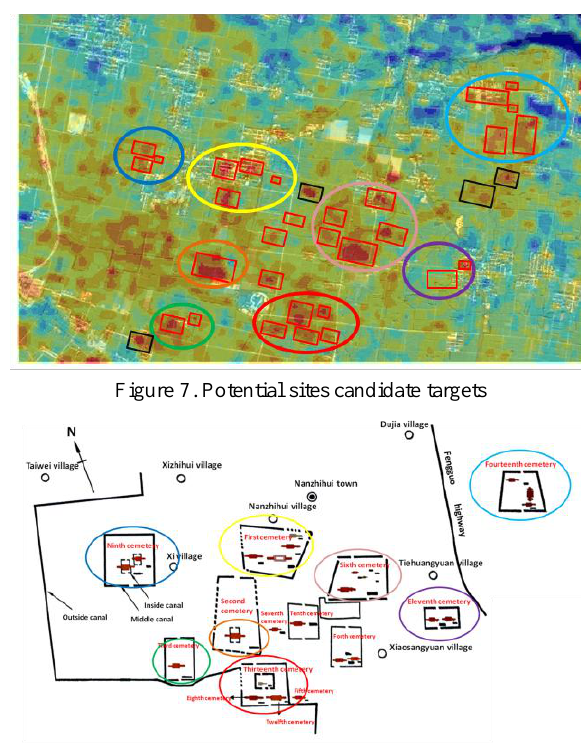
Figure 8. The existed sites location